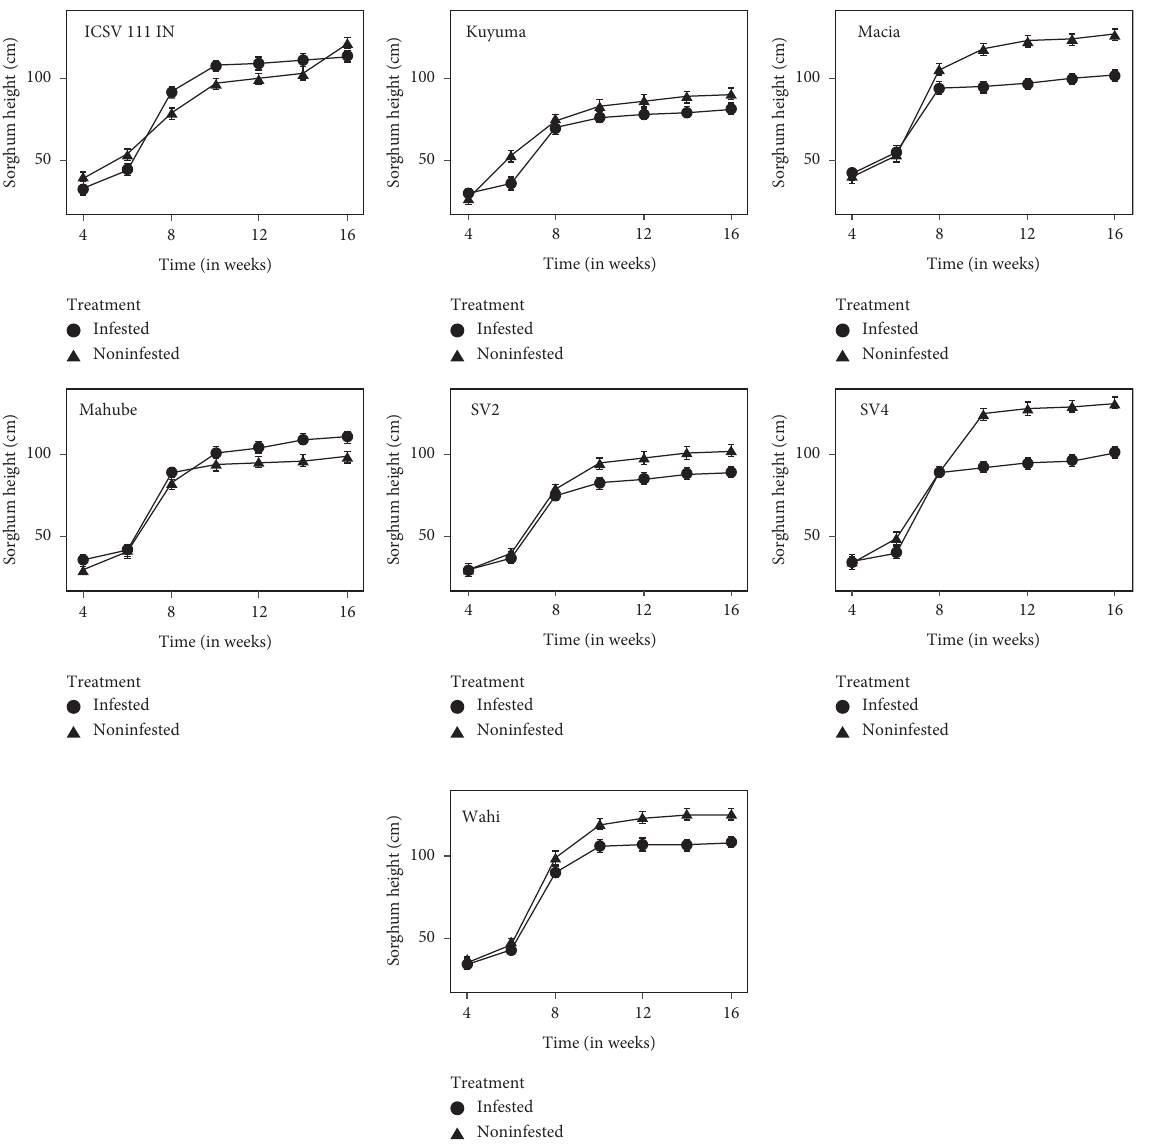
Figure 1: Effect of S. asiatica infection on sorghum height recorded in the pot experiment. Error bars indicate LSD at p < 0 .